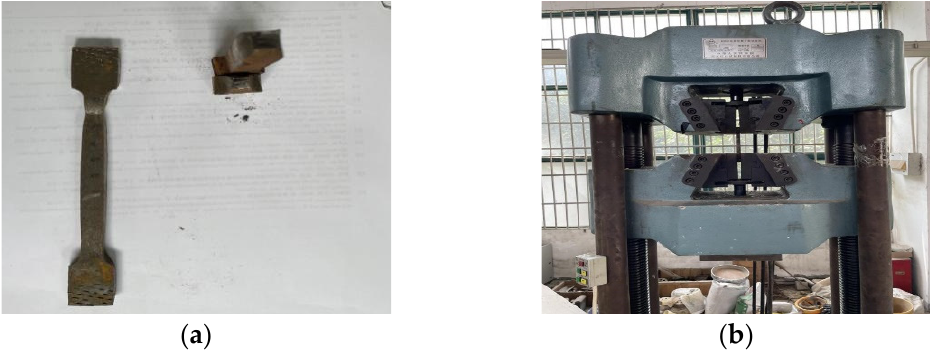
Figure 9. Steel compression test: ( a ) steel specimen; ( b ) electric servo universal testing machine. Table 1. Material properties of autoclaved lightweight concrete.